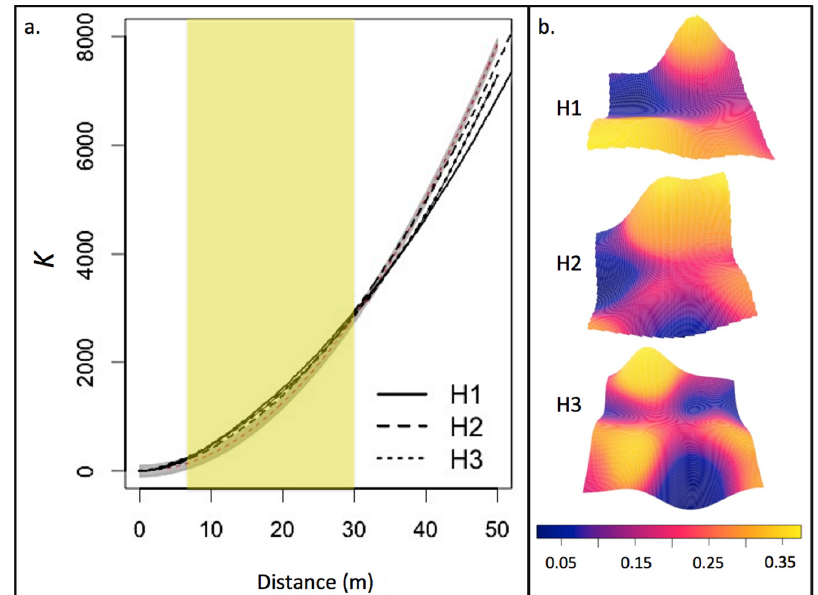
Figure 2. ( a ) Ripley’s K for residual trees in the Hayman Fire plots (H1, H2, and H3). A clustered point pattern is indicated by an observed K(r) (black lines) that is above the complete spatial randomness (CSR) simulated envelope (gray shaded region), whereas a regular point pattern is indicated by an observed K(r) that falls below the envelope. Trees exhibited clustering at distances up to ~30 m (yellow shaded region); ( b ) Perspective plots of residual tree density (trees m − 2 ) in the Hayman Fire, with density represented by the height and color of the plot.